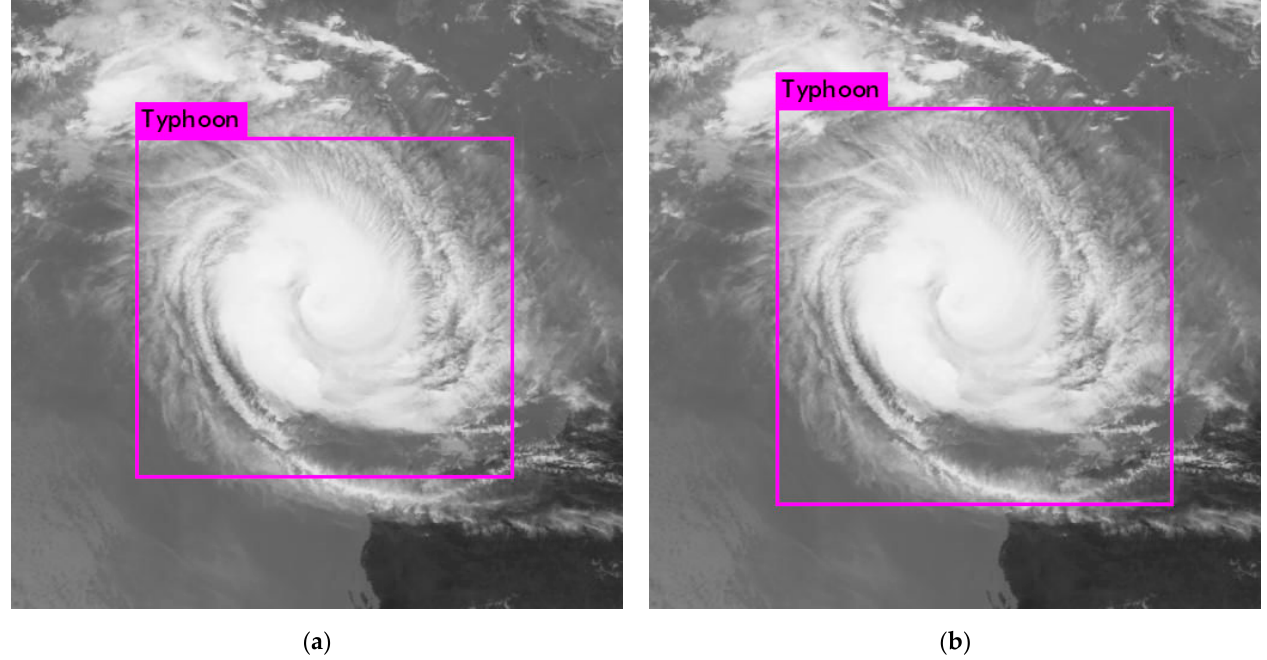
Figure 5. An example of TC detection results, which is the super typhoon Marcus in 2018. ( a ) The detection result of YOLOv3; ( b ) the detection result of NDFTC.